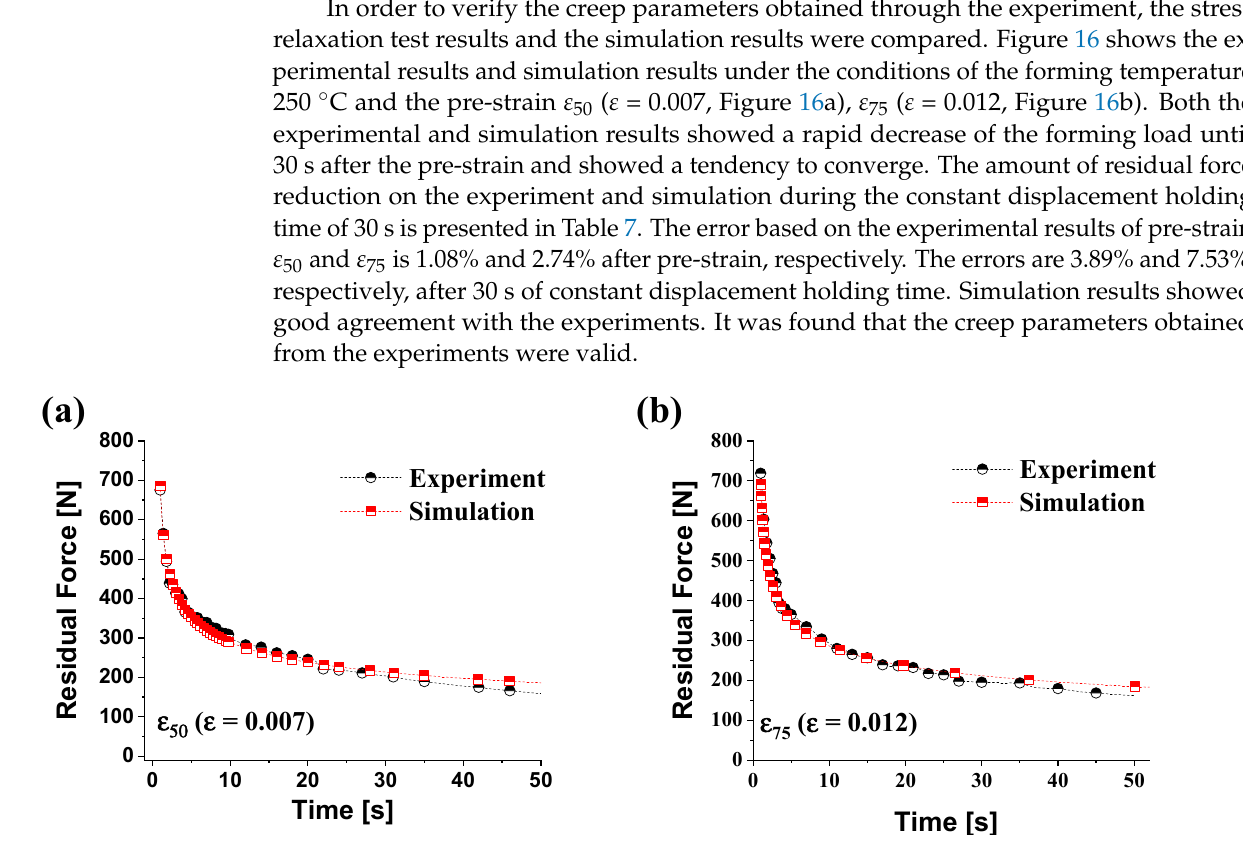
Figure 16. The comparison of the residual stress with the experimental and simulation results at the forming temperature of 250 °C and pre-strain of ( a ) ε 50 ( ε = 0.007), ( b ) ε 75 ( ε = 0.012). Table 7. The amount of residual force reduction in experiment and simulation at 250 °C. Amount of Residual Force Reduction (N) Constant Displacement Holding Time